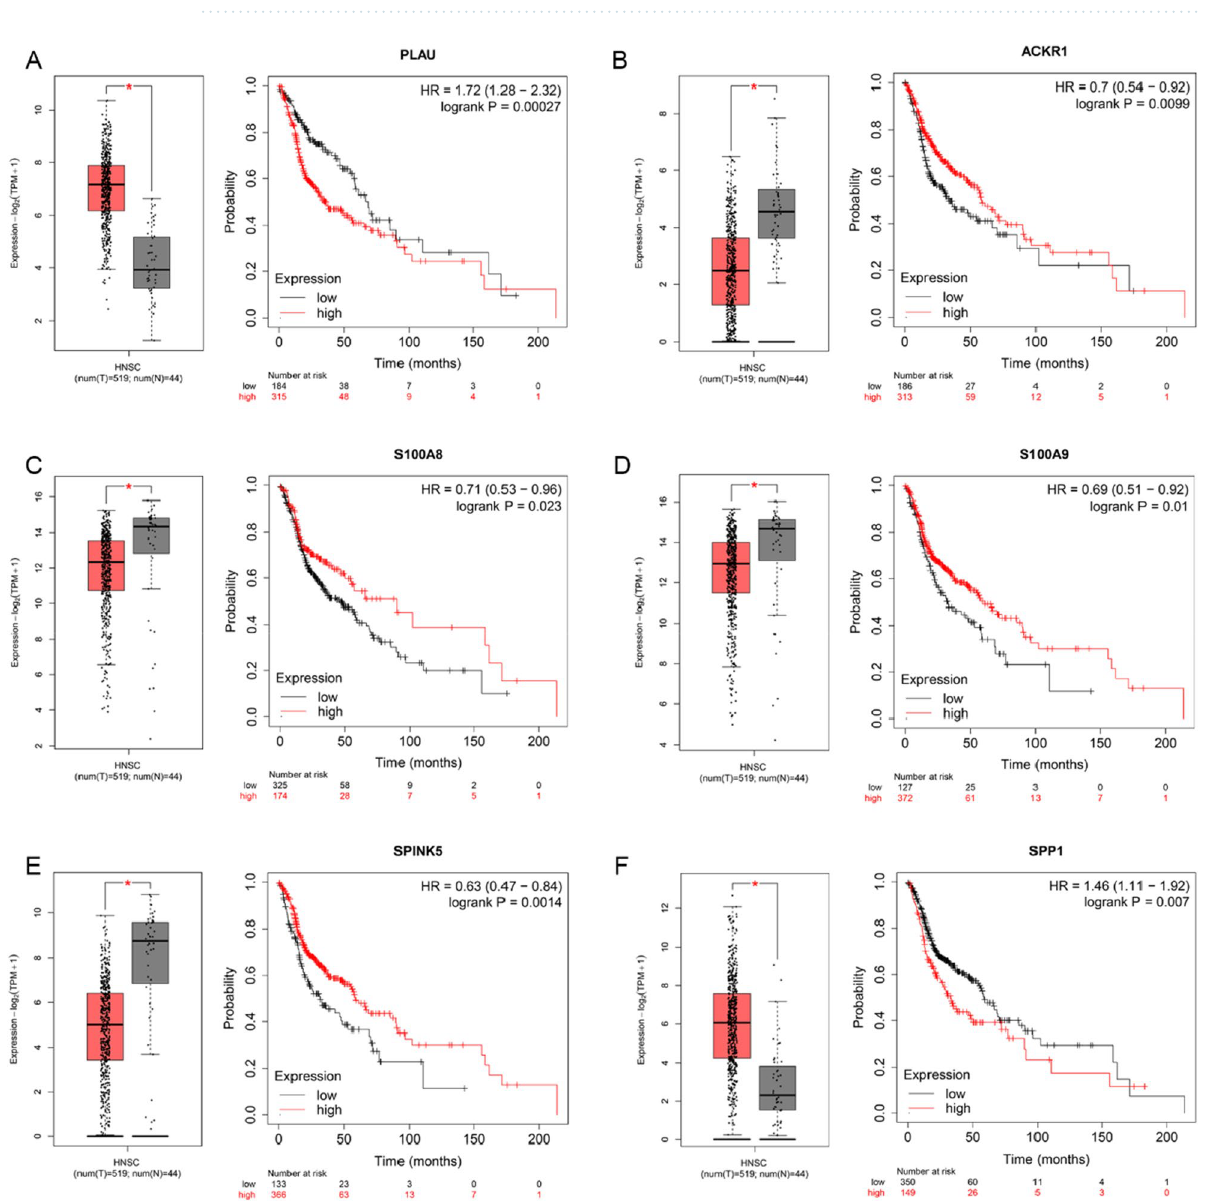
Figure 4. Hub IRGs expression and prognosis of the HNSCC patients. ( A – F ) Validation of PLUA, SPP1, S100A8, S100A9, SPINK5 and ACKR1 expression roles and prognosis values using GEPIA and KM plotter (*p <